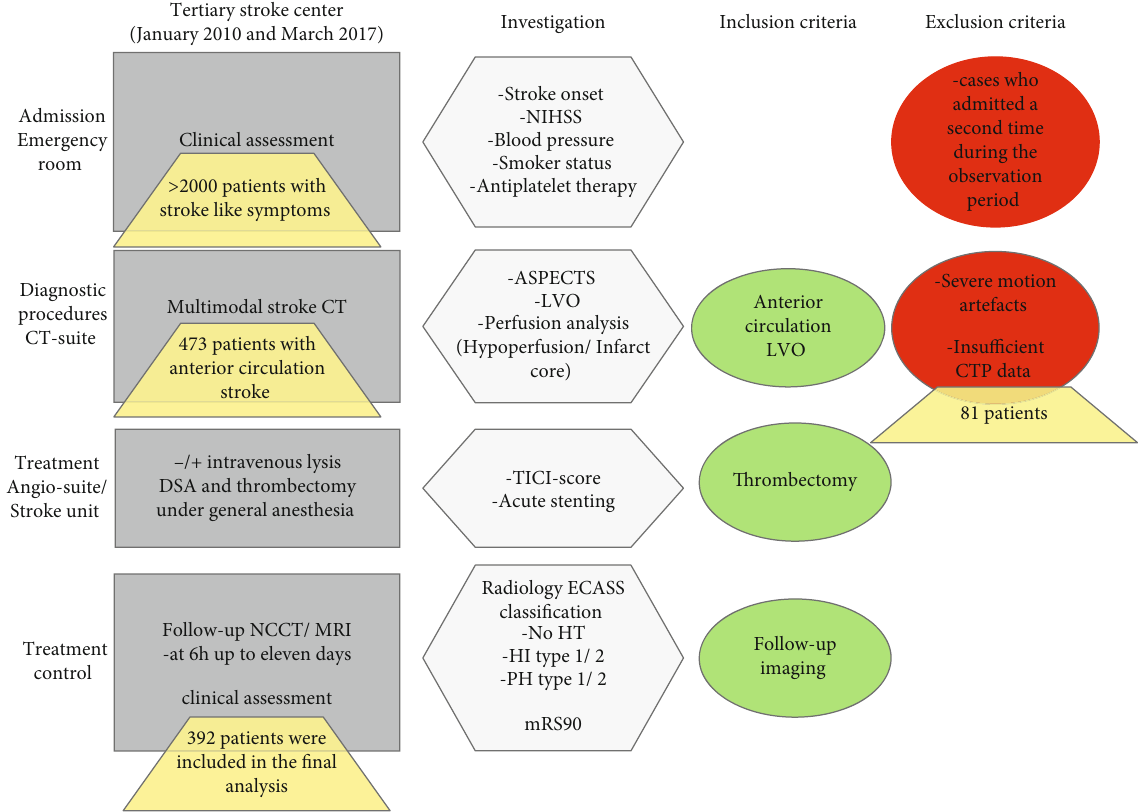
Figure 1: The fl owchart shows the stroke work fl ow in our tertiary stroke center with standardized clinical and imaging assessment, treatment, and follow-up and also the fi nally included patients.